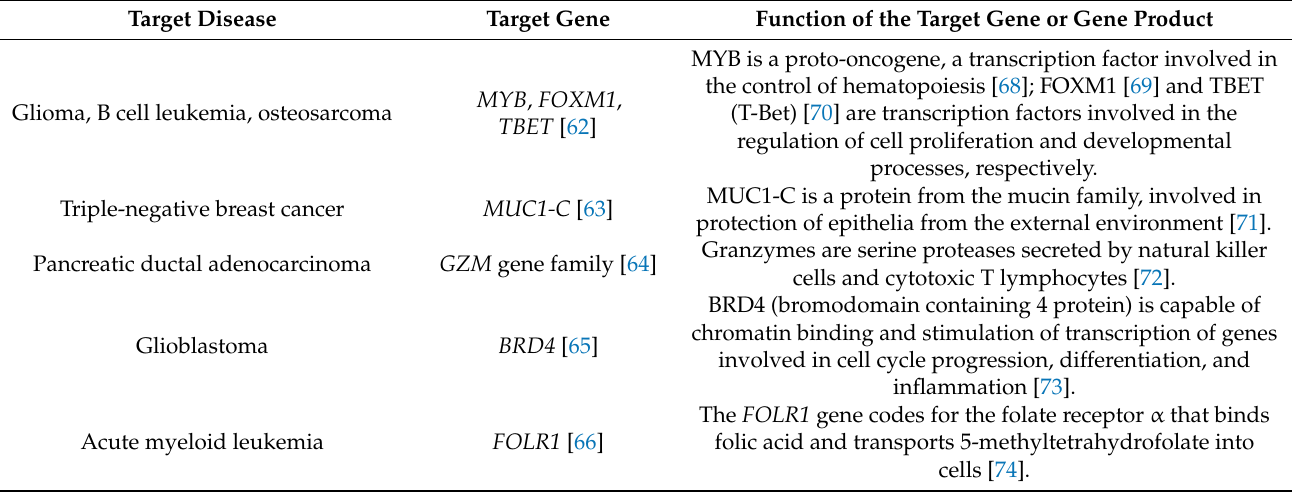
Table 5. New target diseases for CAR-T therapies identified by using transcriptomics. Target